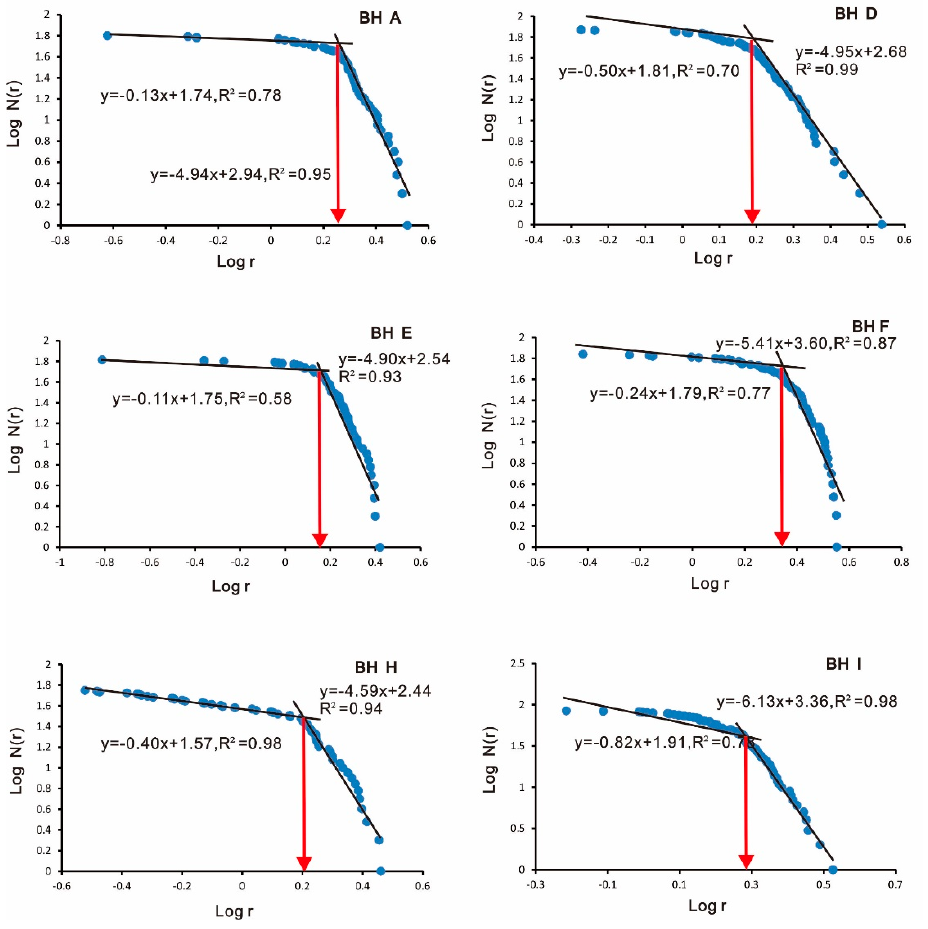
Figure 4. Log–log plots of the cumulative number of samples versus total organic carbon .